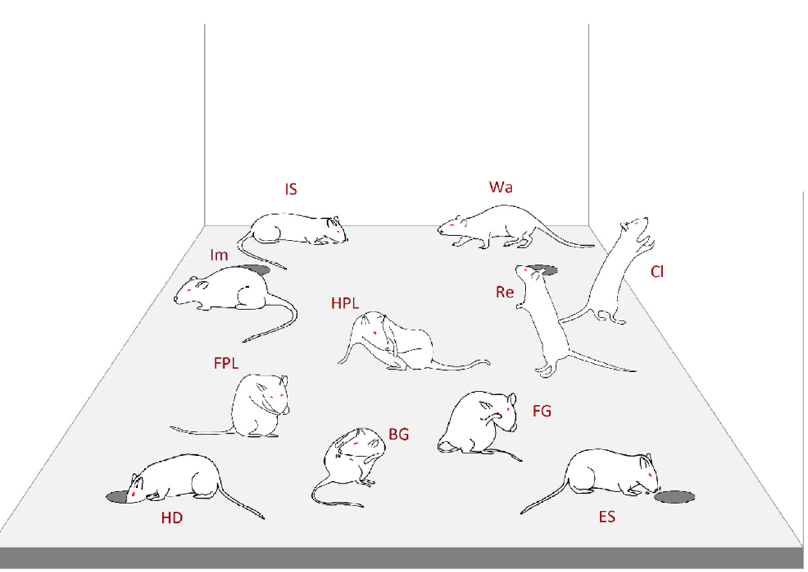
Figure 1. Behavioral repertoire of rat in the HB apparatus. Walking ( Wa ): rat walks around sniffing the environment; Immobile-Sniffing ( IS ): rat sniffs the environment standing on the ground; Climbing ( Cl ): rat maintains an erect posture leaning against the Plexiglass wall; Rearing ( Re ): rat maintains an erect posture without leaning against the Plexiglass box; Immobility ( Im ): rat maintains a fixed posture and no movements are produced; Front-Paw Licking ( FPL ): rat licks or grooms its forepaws; Hind-Paw Licking ( HPL ): rat licks or grooms its hind paws; Face Grooming ( FG ): rat rubs its face (ears, mouth, vibrissae, eyes) with rapid circular movements of its forepaws; Body Grooming ( BG ): rat licks its body combing its fur with fast movements of incisors; Edge-Sniff ( ES ): rat sniffs the border of one of the four holes; Head-Dip ( HD ): rat puts its head into one of the four holes.